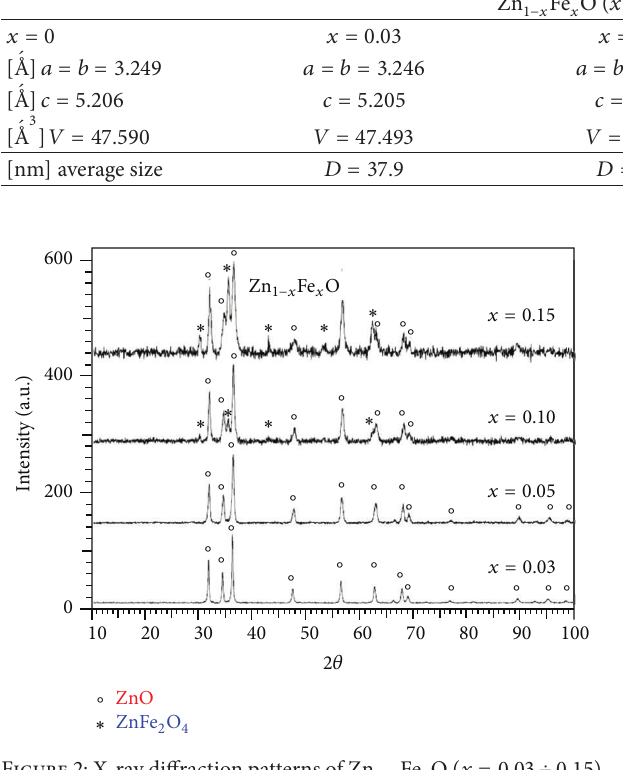
Figure 2: X-ray diffraction patterns of Zn 1−𝑥 Fe 𝑥 O ( 𝑥 = 0.03 ÷ 0.15 ) thin film